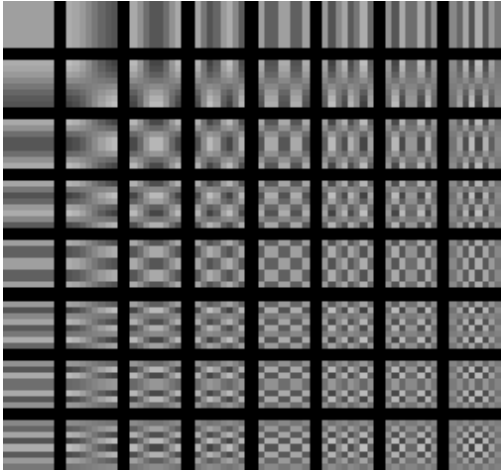
Figure 2. 64 Basis functions of an 8-by-8